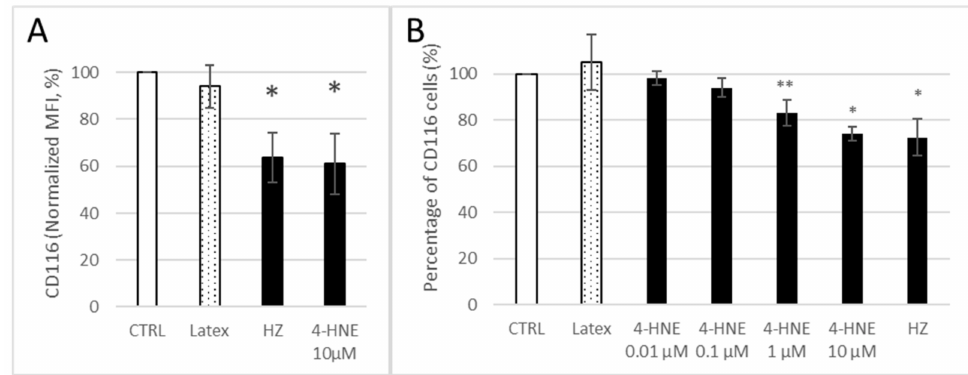
Figure 5. Inhibition of surface expression of CD116 in HZ-fed or 4-HNE-treated monocytes. Mono- cytes were kept as untreated controls (CTRL), fed with neutral latex beads (Latex) or HZ, or treated with different concentrations of 4-HNE as indicated ( A , B ). The surface expression of CD116 was quantified by flow cytometry after immune staining and acquired as MFI ( A ) or percentage of GM-CSF R-positive cells ( B ). Obtained relative MFI and share of CD116-positive treated cells were referred to the respective values measured in untreated control cells from the same donor. Means ± SE of experiments made with monocytes from 3–8 donors. The significances of differences between unfed control and treated cells: ** for p < 0.05, * for p < 0.01.